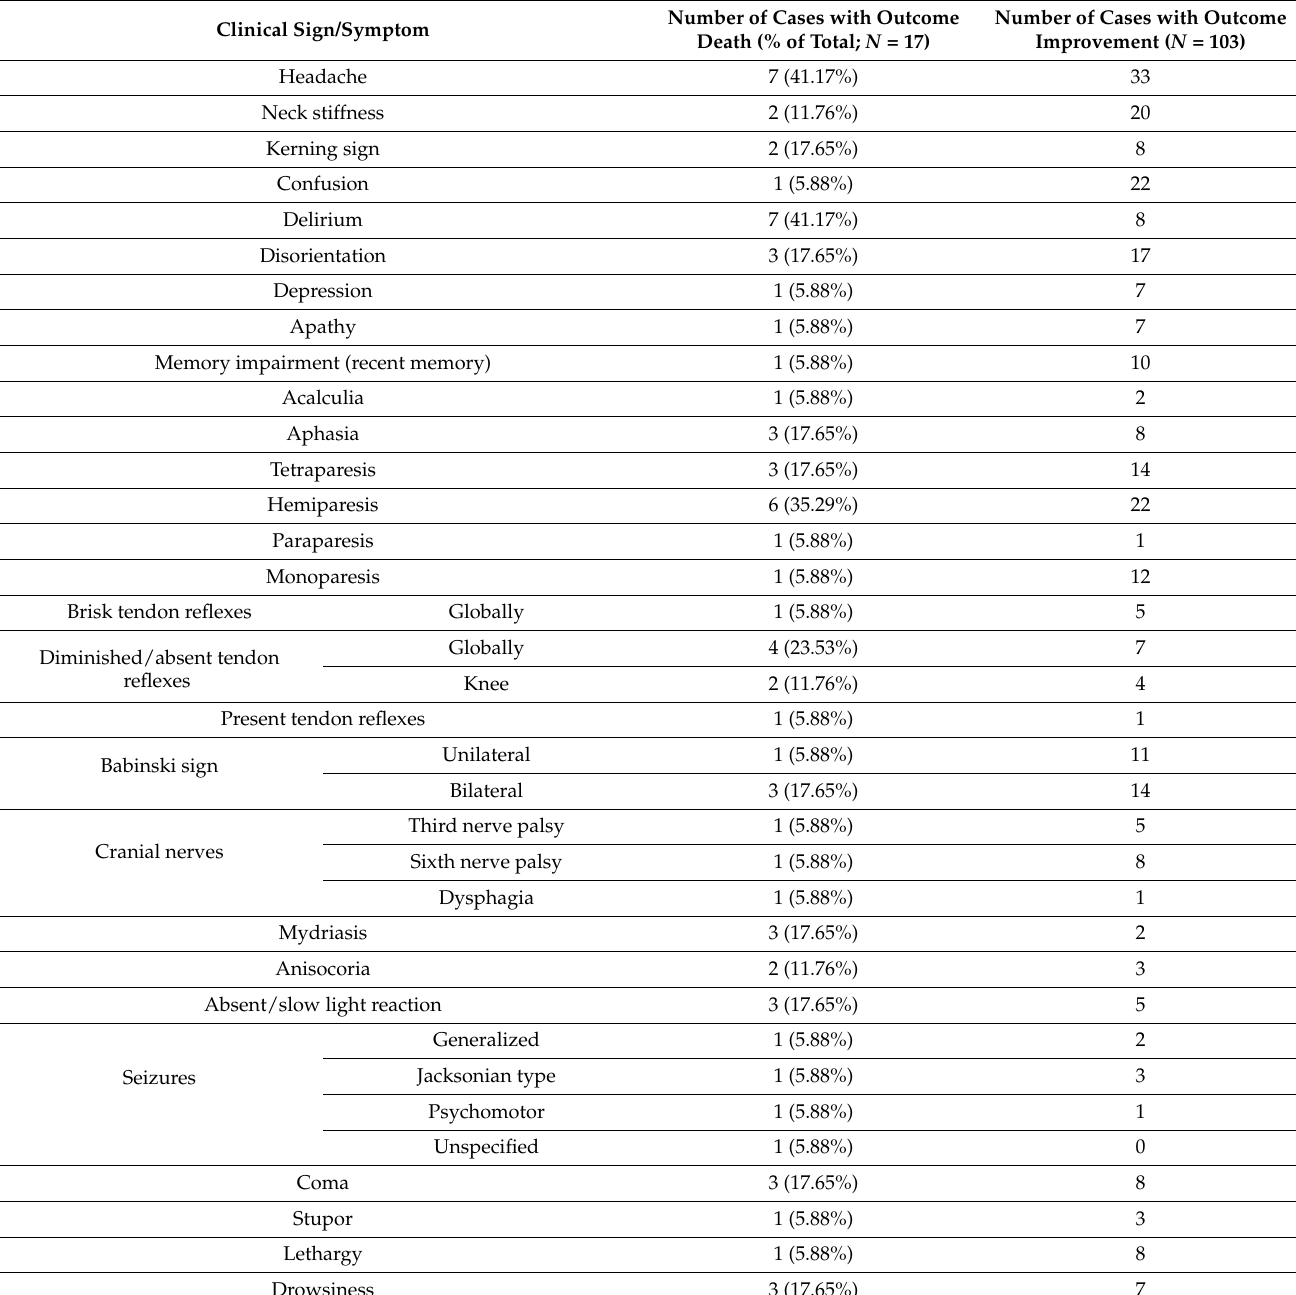
Table 2. Clinical signs and symptoms of cases with reported